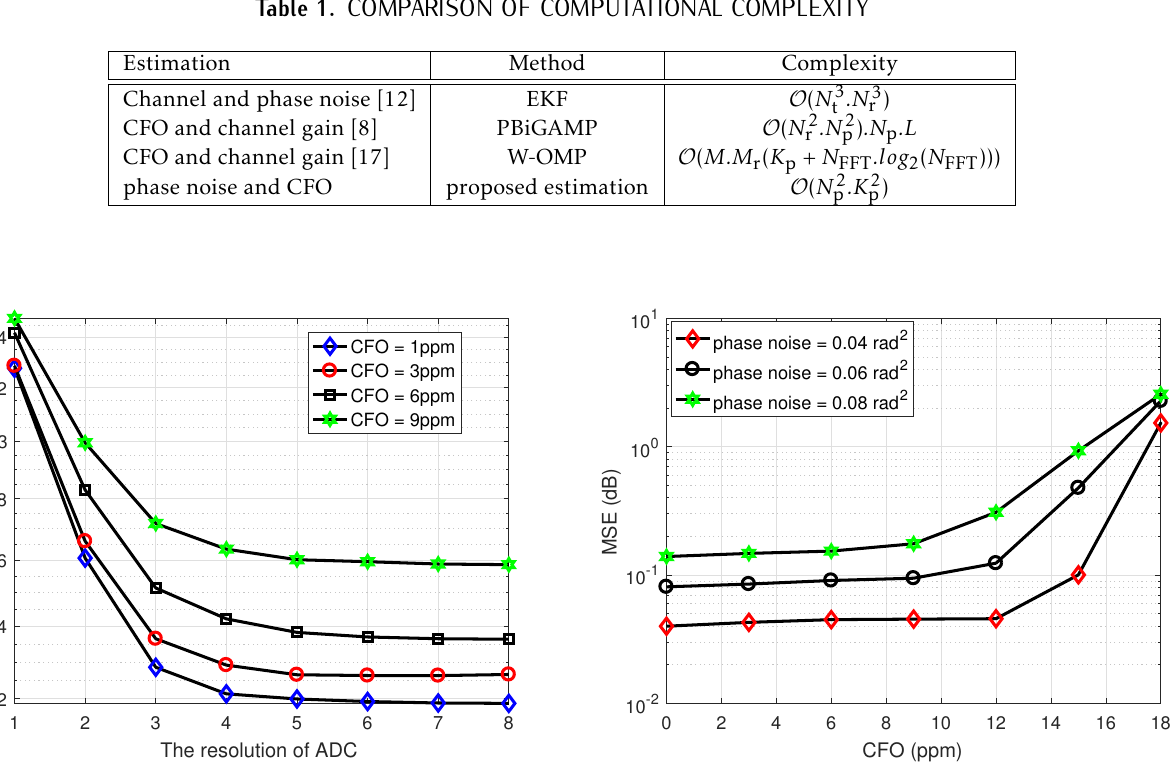
Figure 3. MSE as a function of the resolution ADC, phase noise variance is 10 − 2 rad 2 .